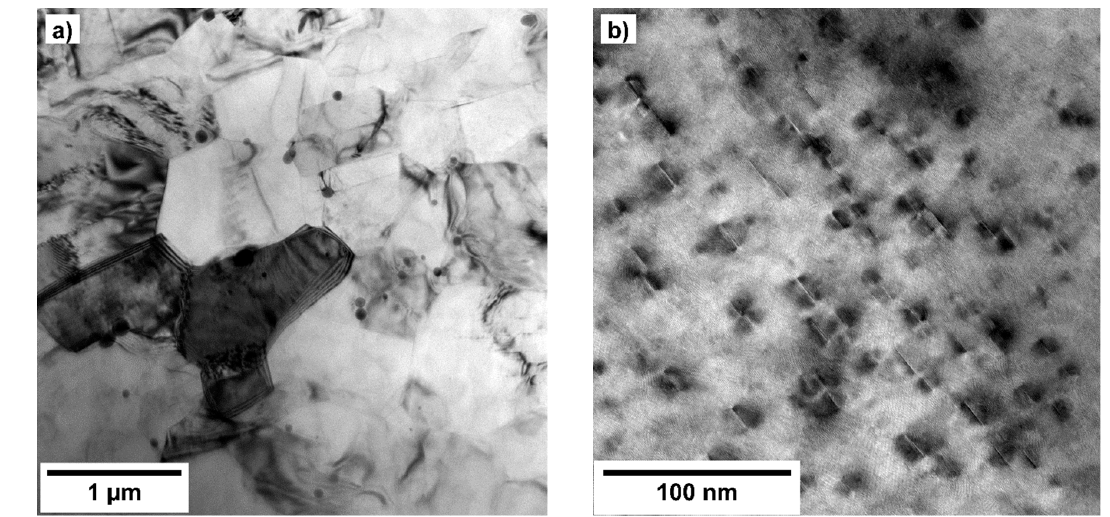
Figure 6. TEM images of ( a ) 1P sample and ( b ) 4P sample.